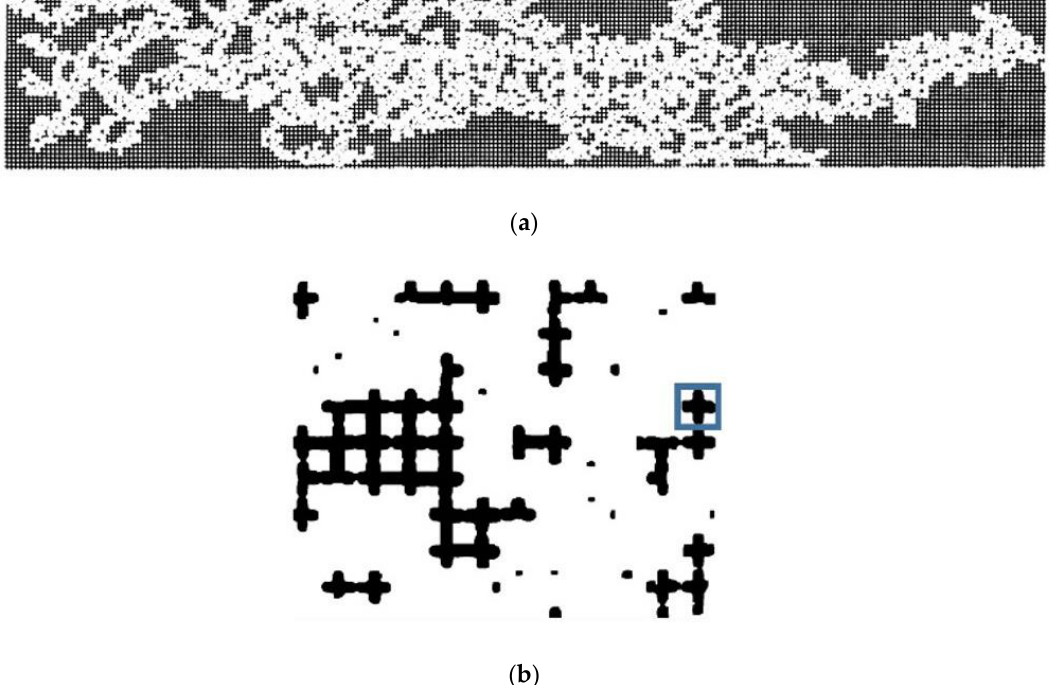
Figure 4. Examples of images after processing: ( a ) oil phase distribution in the entire model pore network; ( b ) zoom in of a small portion of the network showing oil ganglia of different sizes.